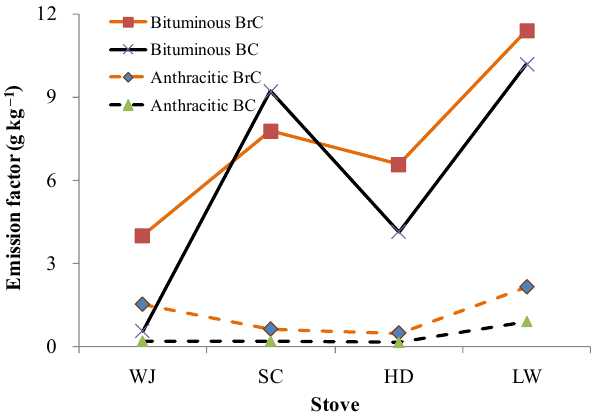
Figure 4. Comparison of emission factors between bituminous and anthracitic coals. The four stoves are Wanjia brand briquette stove (WJ), simple chunk stove (SC), Huanding brand chunk stove (HD), and Laowan brand chunk stove